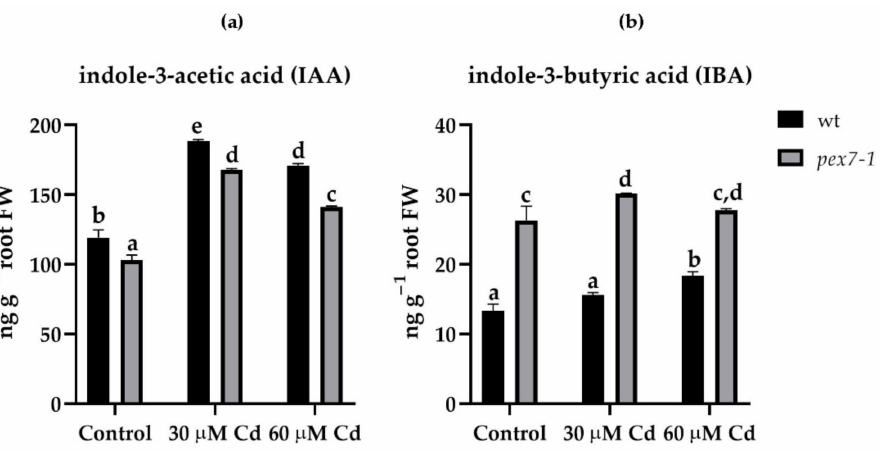
Figure 3. Mean values ( ± SE) from three technical replicates of IAA ( a ) and IBA ( b ) content (ng g − 1 FW) in roots of wt and pex7-1 seedlings not exposed (Control) or exposed to 30 µ M CdSO 4 (30 µ M Cd) or 60 µ M CdSO 4 (60 µ M Cd). Columns labelled with different letters show statistical differences for at least p < 0.05 among treatments within the same genotype and between genotypes within the same treatment. Columns labelled with the same letter are not statistically different ( p > 0.05). Data from the first biological